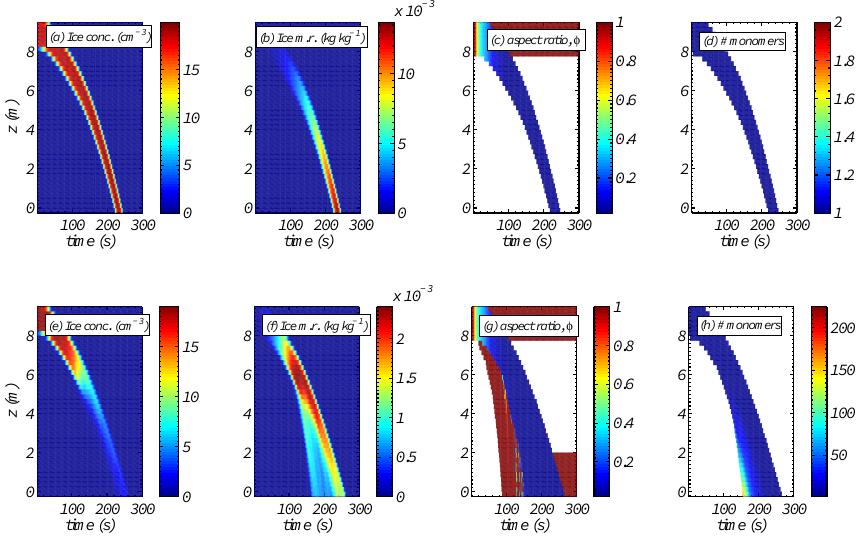
Fig. 11. Model run with E agg set to zero (top plots) and E agg set to unity (bottom plots). Table 2. Ice crystal aspect ratio observed with the CPI (approx.) and that modelled using the standard inherent growth ratio and the modified inherent growth ratio (see text for details). The modelled aspect ratio, φ is given as the first number in the column and the inherent growth ratio, 0(T ) is given as the second number in